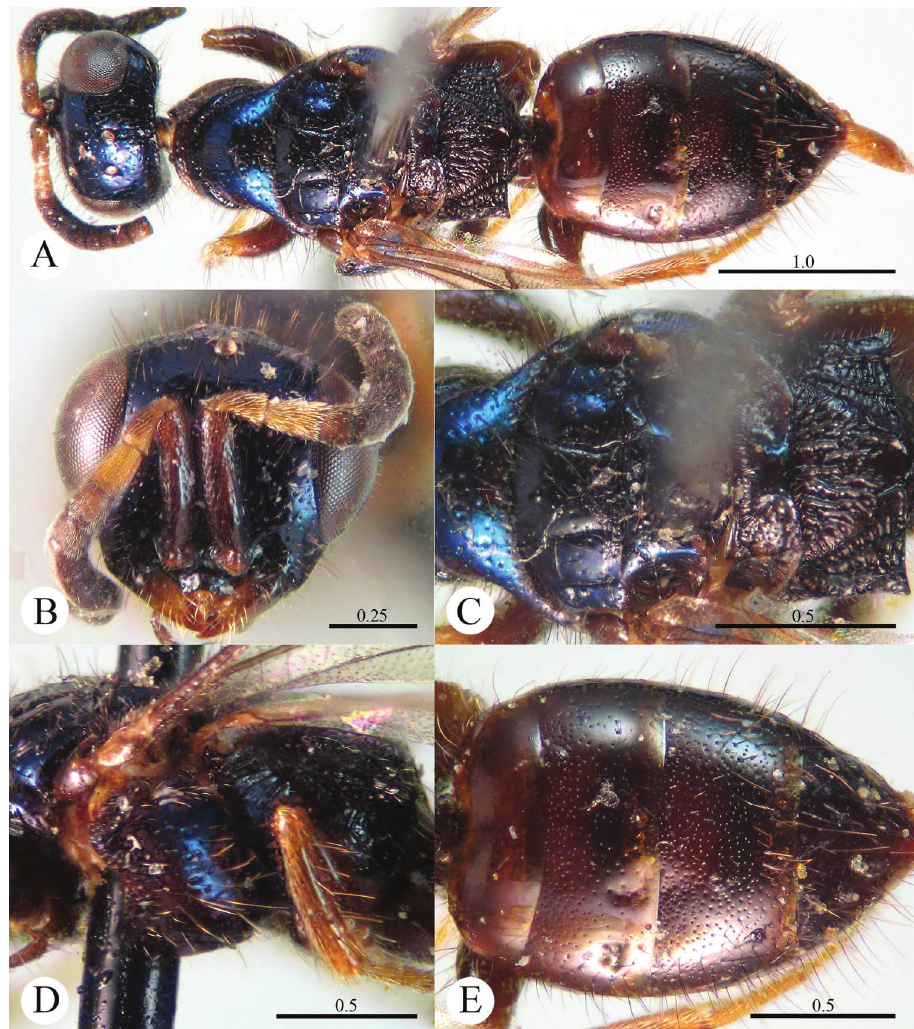
Plate 6. Cleptes mareki Rosa, 2003, paratype, female from Shanxi. A Habitus dorsal B Head anterior C Mesosoma dorsal D Mesopleuron and metapleuron lateral e Metasoma dorsal. Scale bars in mm. (Photos by Michele Zilioli & Fabrizio